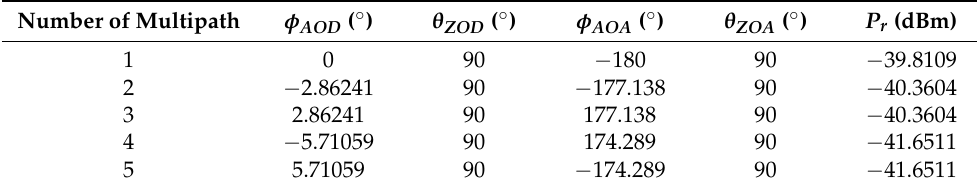
Figure 7. Angle and power of multipath signals ( a ) ZOD, ( b ) AOD, ( c ) ZOA, and ( d ) AOA. Table 3. Angle and power of 5 maximum energy paths.